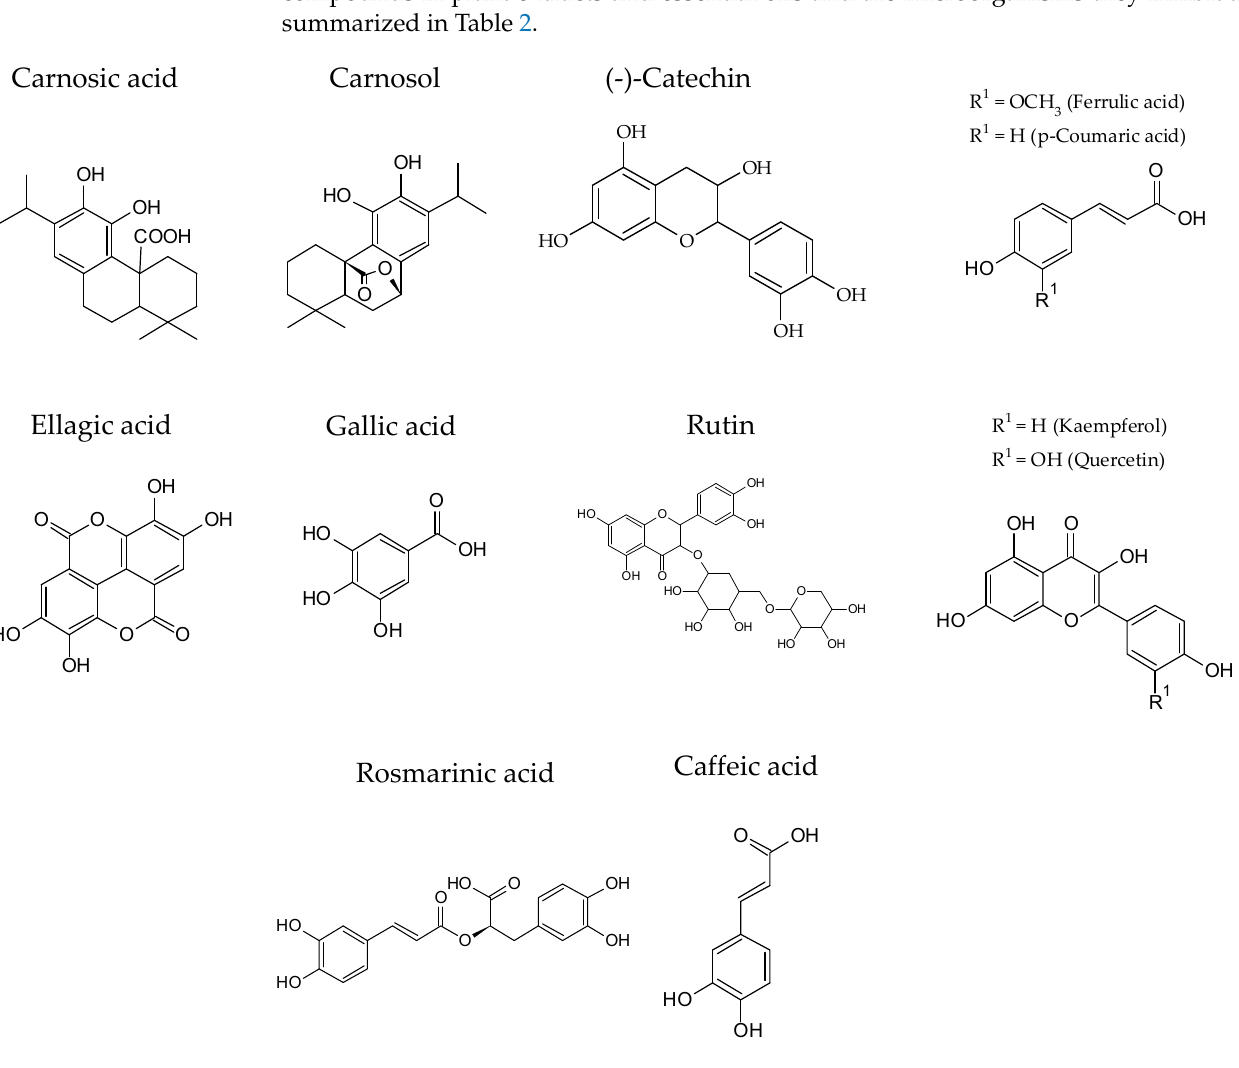
Figure 2. Chemical structures of the main bioactive compounds in plant ‐ based extracts. Red fruit extracts (plum, red grapes, and elderberries) also presented a high micro ‐ bial inhibition against pathogens B. cereus , S. aureus , and E. coli , which is related to the high anthocyanins contents of the extracts. Although these extracts presented a high anti ‐ microbial activity against pathogens, it is important to highlight that they stimulated the growth of the probiotic bacteria [82].